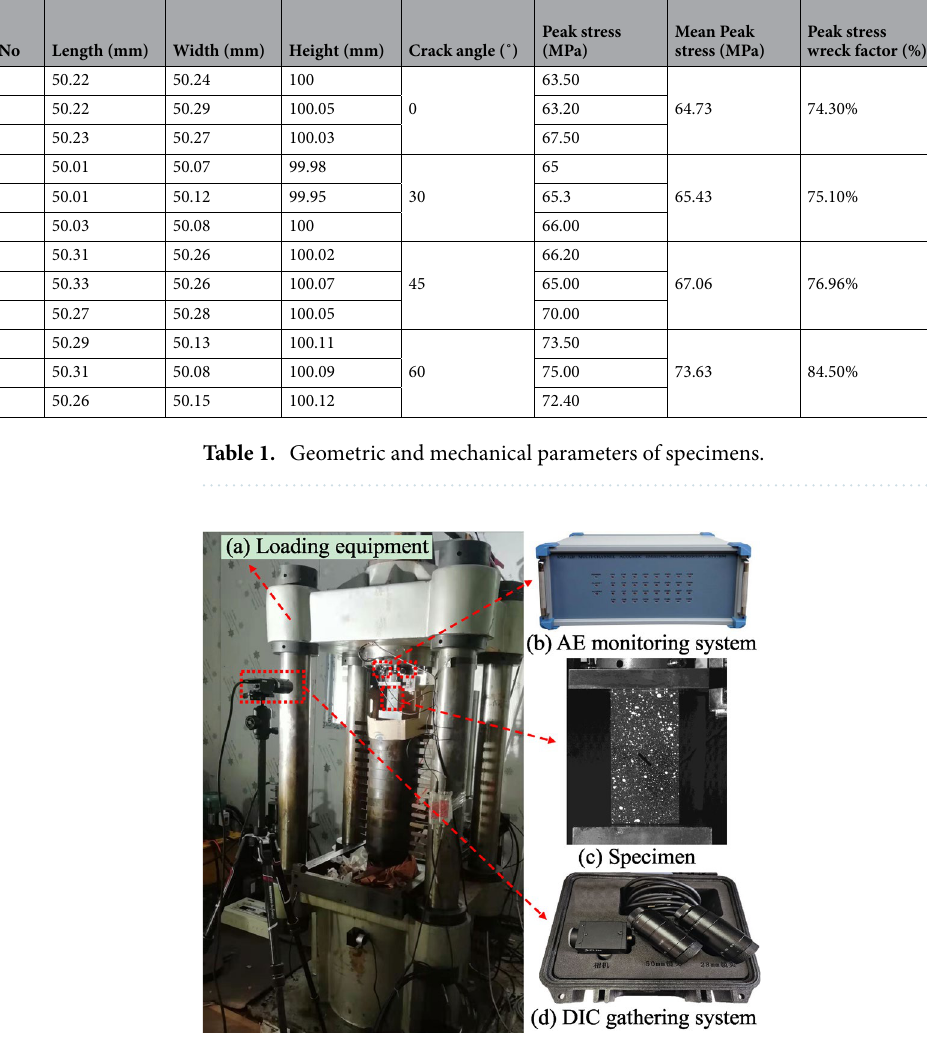
Figure 2. Layout of loading equipment and monitoring